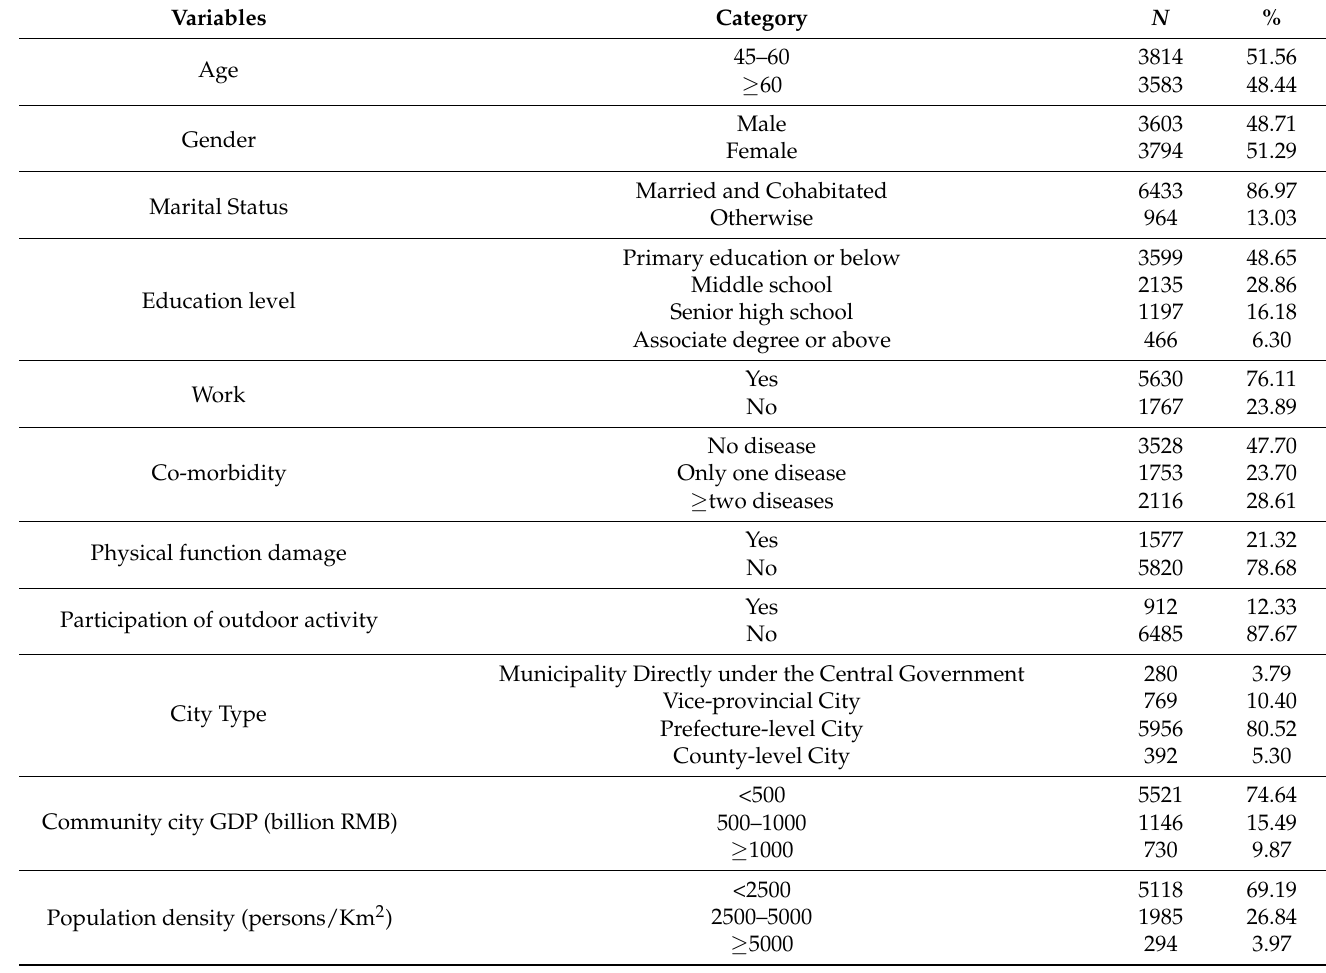
Table 2. Study sample